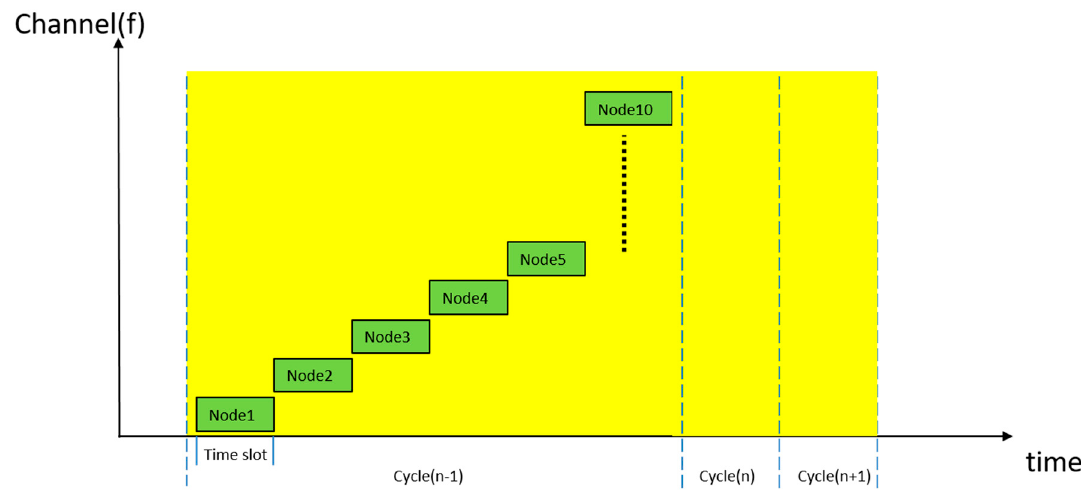
Figure 11. The diagram shows that sensor nodes communicate with sink node in two domains.